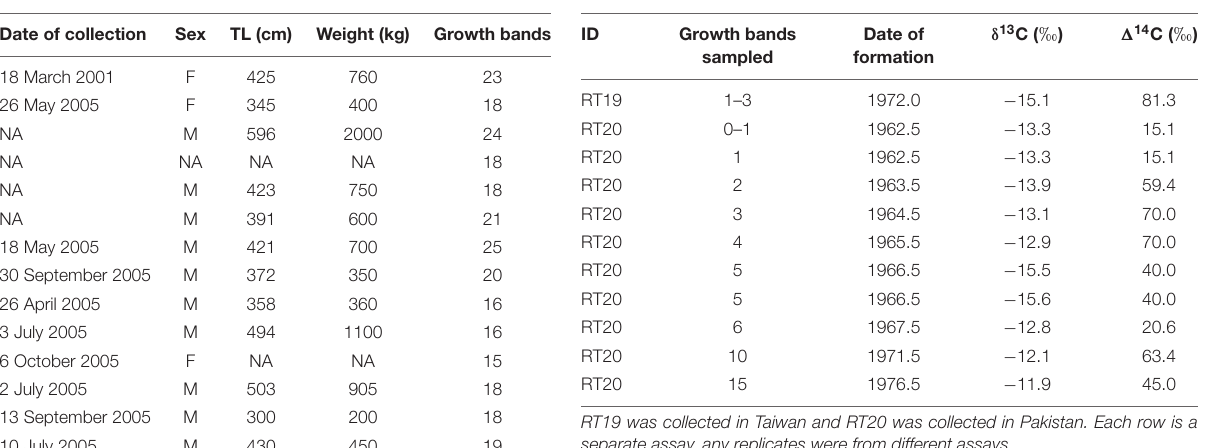
TABLE 1 | Summary details for vertebral